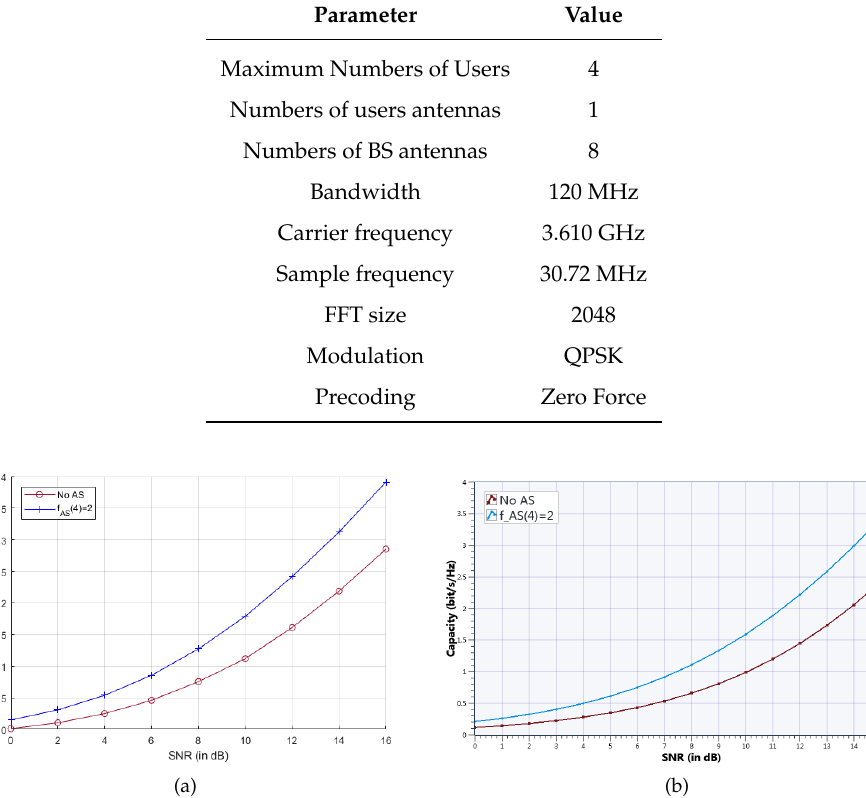
Figure 9. Achievable sum capacity performance comparison of proposed AS aided MU-MIMO system associated with K = 2 active users, N T = 4 transmit RF chains. ( a ) Simulation result from MATLAB. ( b ) Measurement result from NI SDR platform.